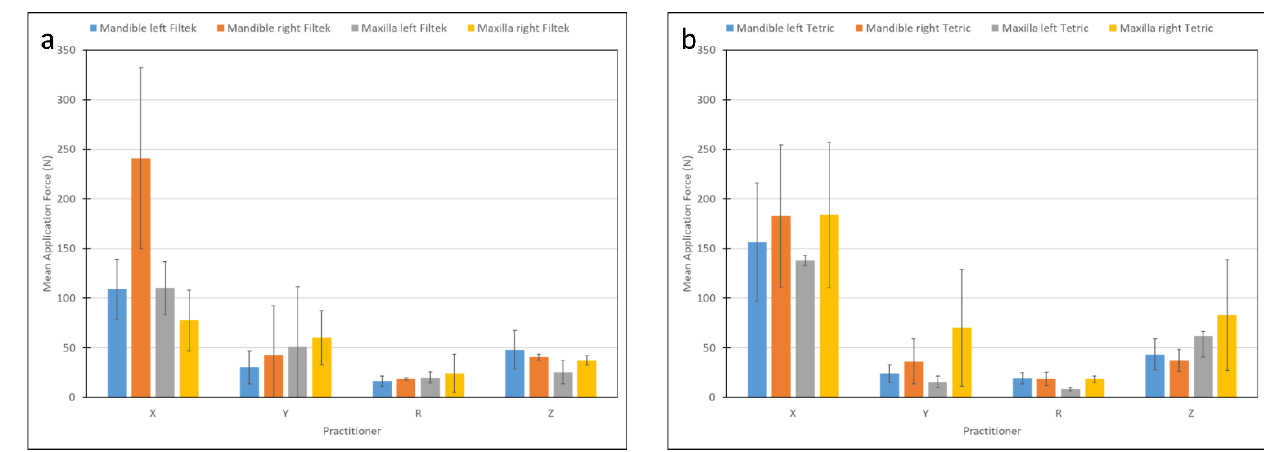
Figure 6. Mean application force as related to practitioner and materials: ( a ) Filtek, ( b ) Tetric. The number of peaks (Figure 7) were affected by the side ( p < 0.03). Specifically, less peaks were found on the left side. The interaction between jaw and side was significant ( p < 0.016), for example, more peaks and a higher mean peak force were found on the left side of the mandible. Figure 7. Number of peaks as related to practitioner and materials: ( a ) Filtek, ( b ) Tetric. 3.2. Compressive Properties No significant differences were found in compressive strength as affected by the res- toration location, participant, or material ( p = 0.431). The stiffness values of Filtek (3729 ± 228 N/mm) were found to be 15% higher compared with Tetric (3248 ± 227 N/mm) ( p < 0.005). No correlations were found between the compressive strength or stiffness and the amount of force applied during placement. 4. Discussion The outcome of this study showed differences in restoration placement parameters between different practitioners and differences between the jaws and sides; however, these differences did not affect the final compressive strength of the bulk-fill resins tested in this study, thus rejecting the hypothesis. The variance in stiffness between the materials could be attributed to the differences in their material compositions.